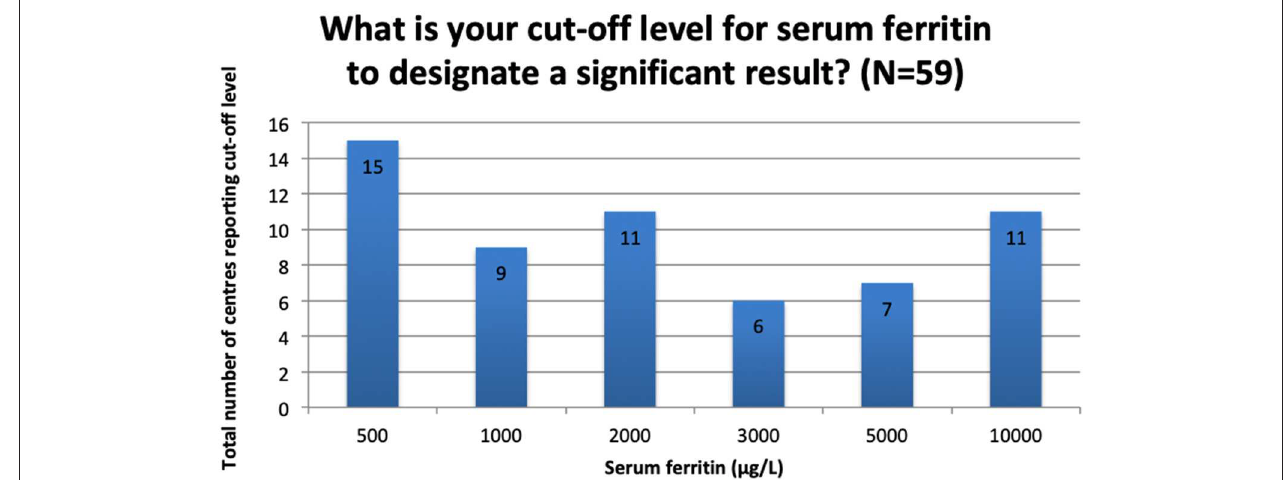
FIGURE 3 | Reported cut-off levels to define a significant serum ferritin result.